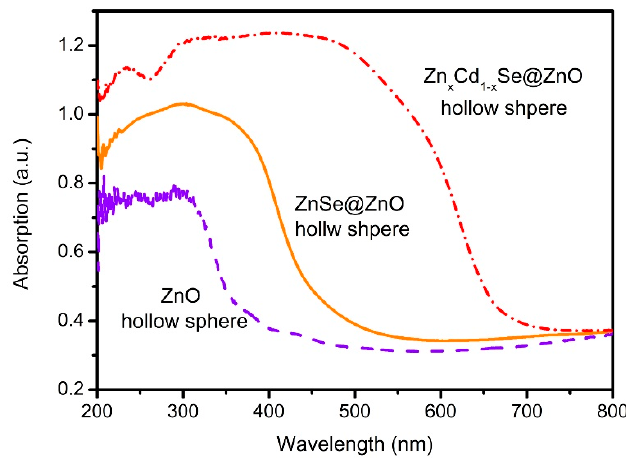
Figure 6. UV-visible absorption spectra of ZnO HS, ZnSe@ZnO HS, and Zn x Cd 1-x Se@ZnO HS photoanodes, respectively.